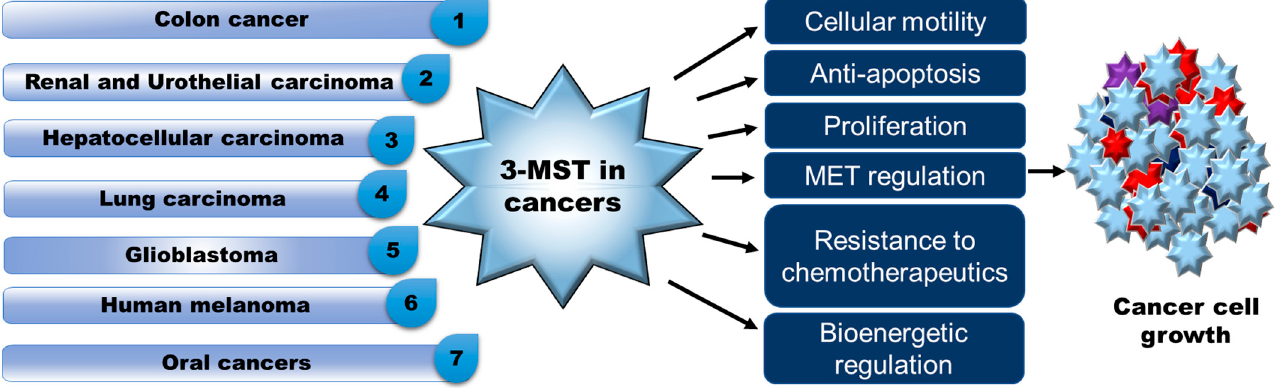
Figure 2. Role of 3-MST in cancer. 3-MST: 3-Mercaptopyruvate, MET: Mesenchymal epithelial transition. 3-MST directly or indirectly plays its critical role in various cancer conditions by regulating pathways involved in the progression of cancers. Pleotropic role 3-MST is observed in different mechanisms regulating cell proliferation and cell death in different cancers.